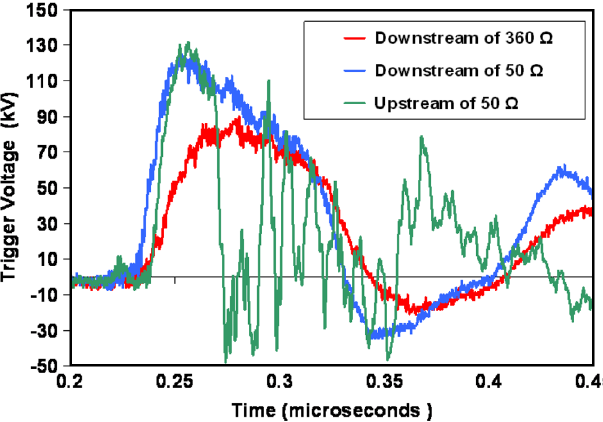
FIG. 26. (Color) Framing camera images of the breakdown of the Kinetech switch after the 40 nF capacitors are charged to (cid:2) 100 kV . Current must flow outside the switch to drive three of the four breakdown arcs seen in the bottom half of the picture.